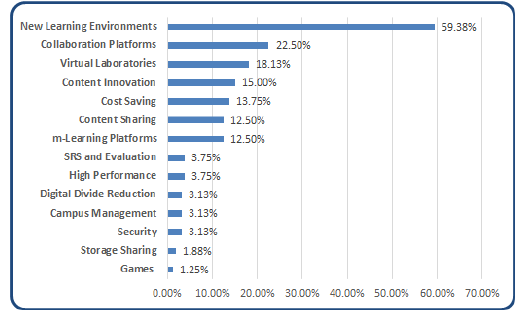
Figure 4. Results of RQ1: topics covered in the empirical papers.